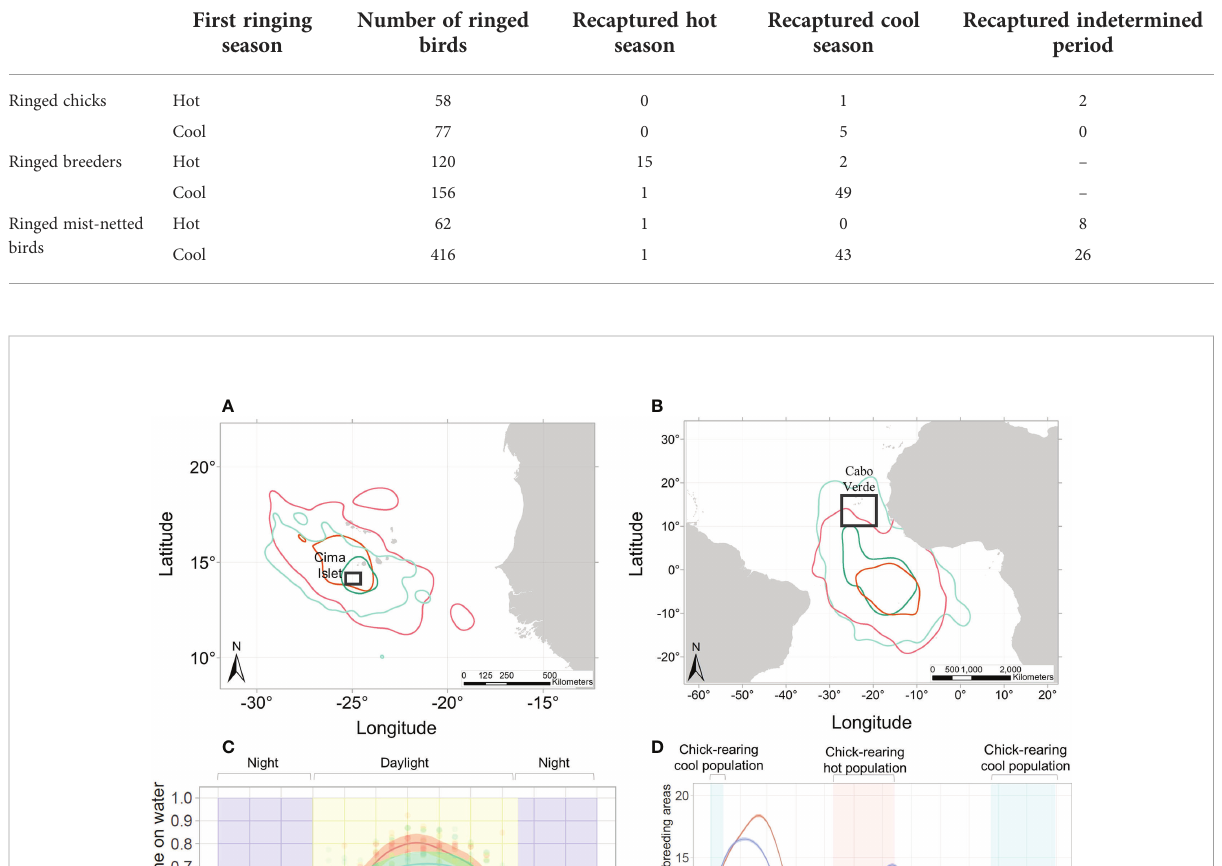
TABLE 1 Summary of the captures and recaptures made for (a) chicks, captured as prospectors in subsequent years; (b) breeders and (c) birds captured through